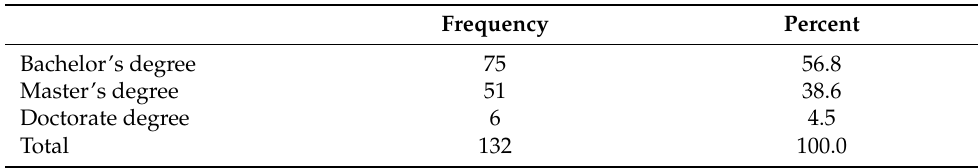
Table 2. Highest level of education.